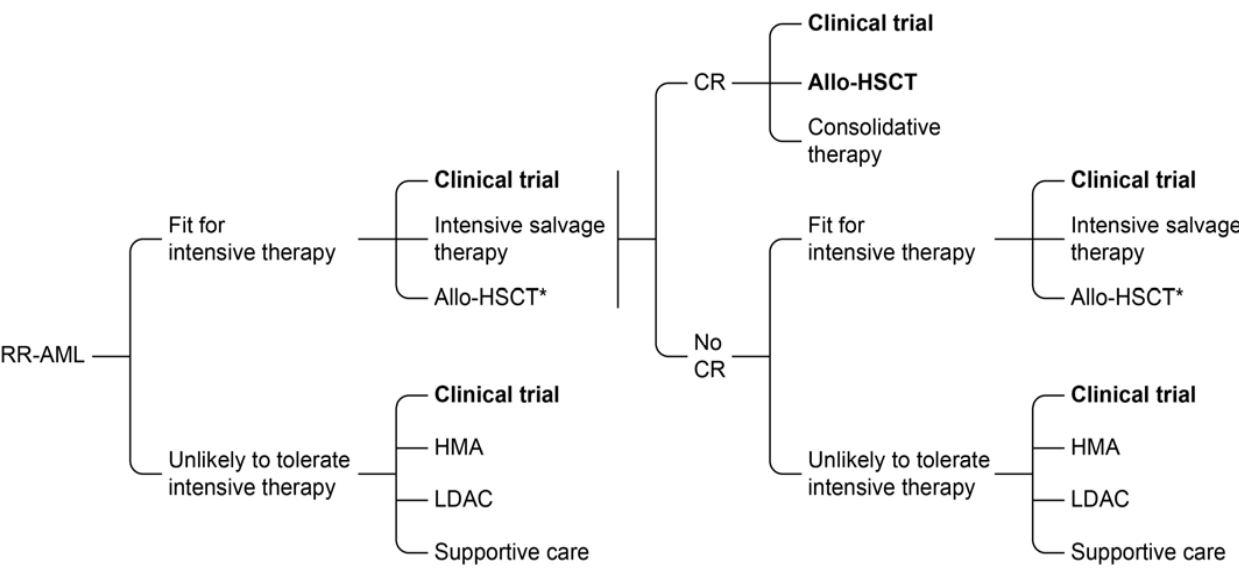
Figure 1. Treatment algorithm for patients with RR-AML in 2015. There is no standard of care for the treatment of relapsed or refractory AML. A clinical trial is always the preferred option. The above algorithm is based on current clinical practice and will hopefully change in coming years due to improvements. In particular the targeted and immunotherapeutic agents detailed in this review may ultimately have utility in (1) initial therapy; (2) as a bridge to, or as a temporizing measure before, allo-HSCT; and/or (3) as part of consolidative therapy. * Achievement of a complete remission (CR) prior to undergoing alloHSCT is associated with best survival and is generally preferred. The survival of patients with residual disease undergoing alloHSCT varies considerably however and this therapy may be a reasonable option in selected patients not